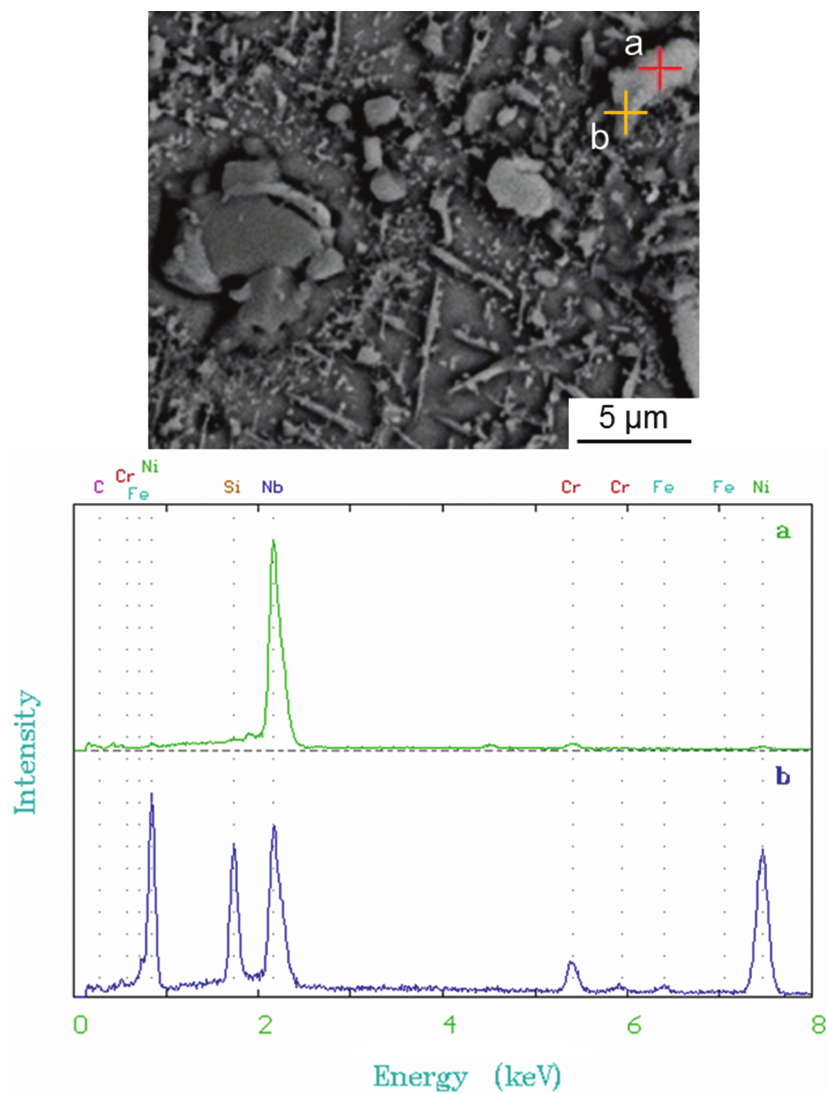
Figure 9: SEM image in backscattered electron mode of a sample from the low-carbon alloy aged for 1000 h showing the partial transformation of a NbC (a) particle into the niobium silicide (b). The EDX spectra are shown at the bottom.